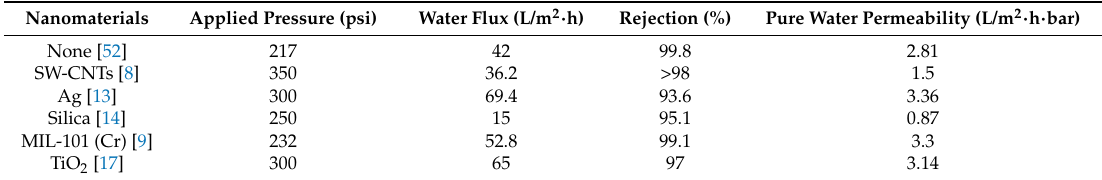
Table A1. Comparison of TFN membrane performances in recent literature. Note: All studies were performed using a feed solution of 2000 ppm NaCl, with the exception of the study with no nanoparticles, which used 1500 ppm